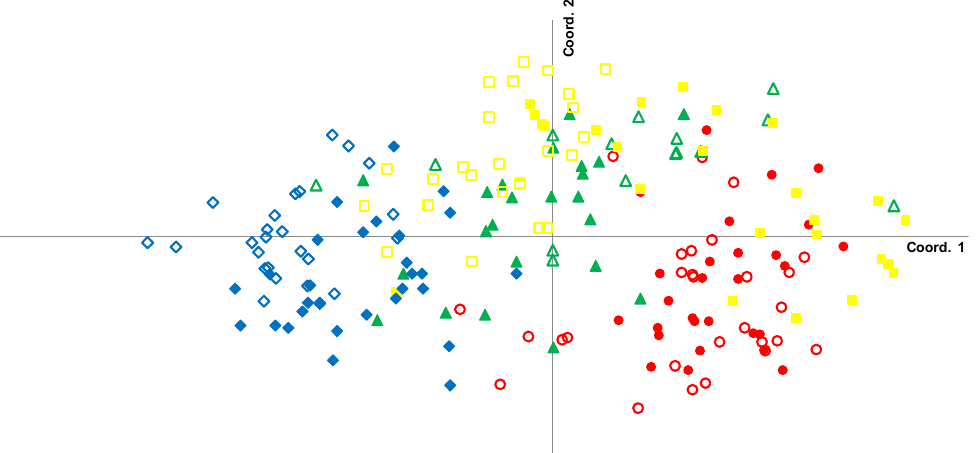
Figure 3. Principal coordinate analysis (PC O A) for the red mangrove, Rhizophora mangle , in the Transverse Coastal Corridor, southern Quintana Roo, Mexico, using ISSR molecular markers. Chetumal Bay (red circle): Tamalcab (solid) and Playa Cayo Venado (empty), Bacalar Lagoon (green triangle): Pedro Santo (solid) and Huub’ Sak (empty), Hondo River (yellow square): entrance (solid) and inward (empty), and Caribbean Coast (blue rhomb): Bacalar Chico (solid) and Xcalak National Reef Park (empty).